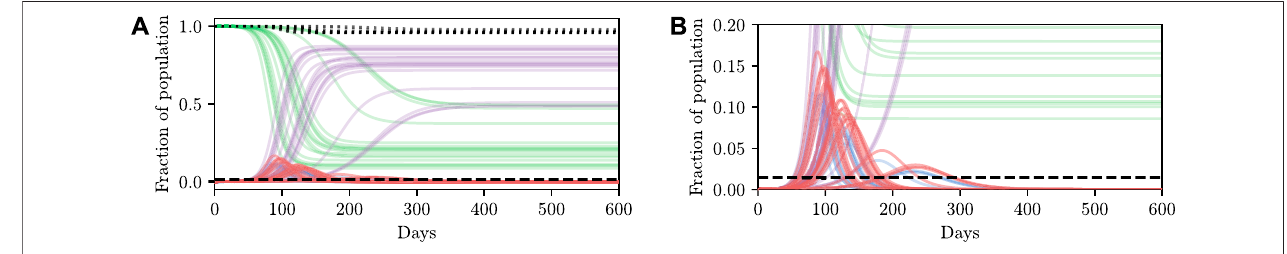
FIGURE 3 | Stochastic simulations from the SEI 3 R model. (A) shows the full trajectory while (B) is cropped to the pertinent region. Compared to the deterministic simulationsin Figure 2A , stochastic simulationshave the capacity tobe much more infectious. Therefore, fully stochastic simulationsare required to accurately quantify the true risk in light of the uncertainty in the model. As a result of this, Bayesian methods, or at least methods that correctly handle uncertainty, are required for robust analysis. We reuse the colour scheme de fi ned in Figure 2A for